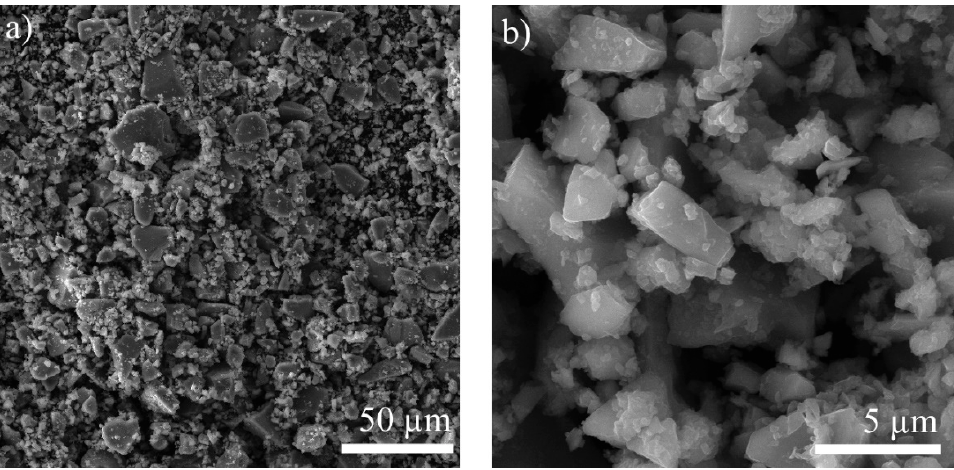
Figure 4. SEM images of milled Ecuadorian BMS in lower ( a ) and higher ( b ) magnifications.